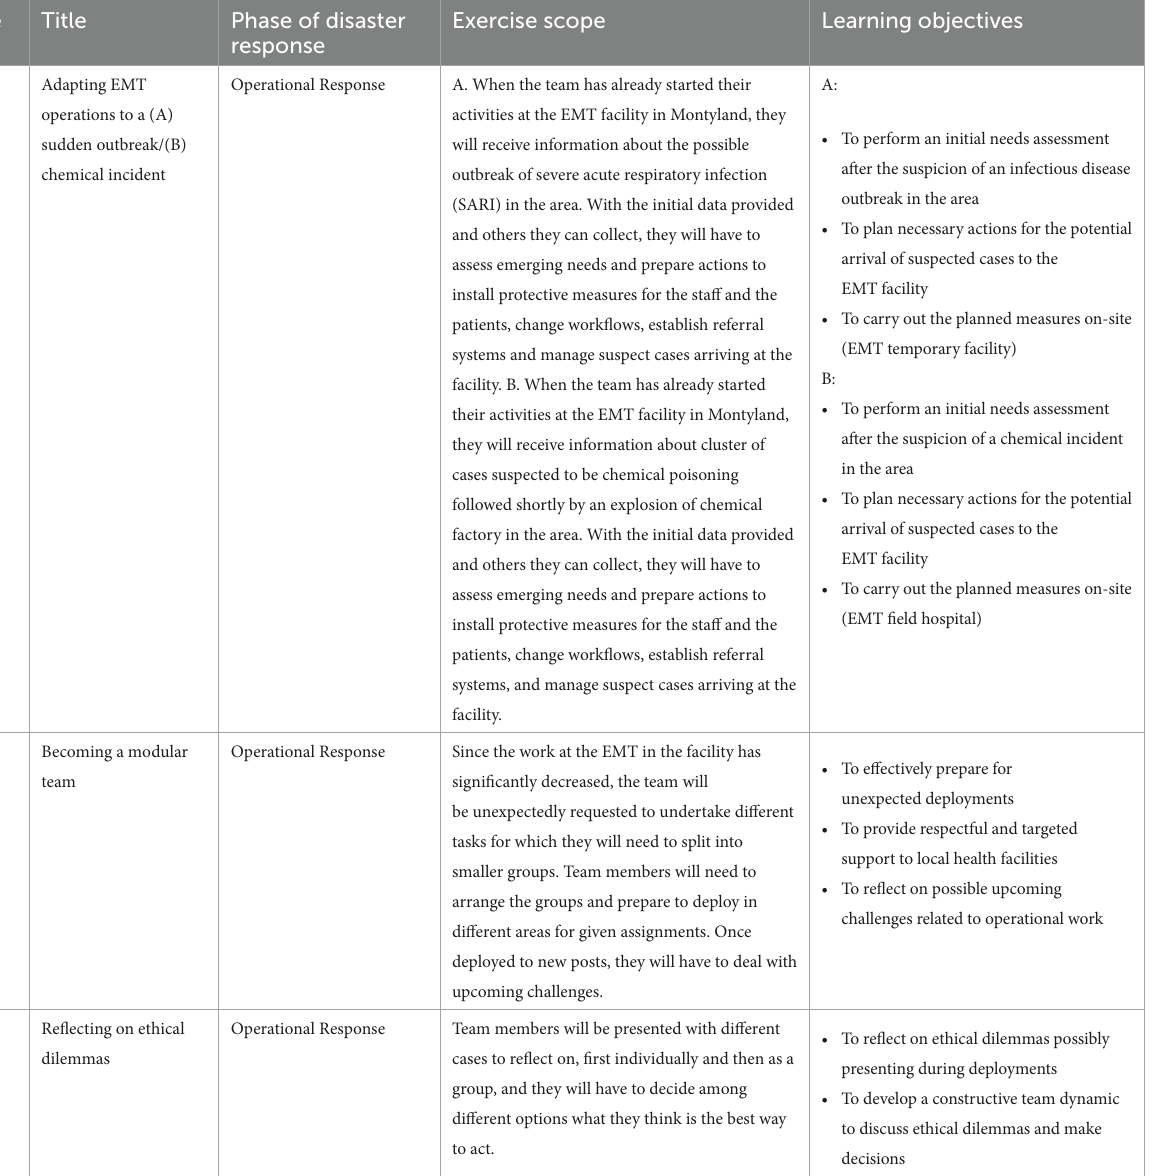
TABLE 2 Outline of three new exercises added to the original training package (See above). Exercise